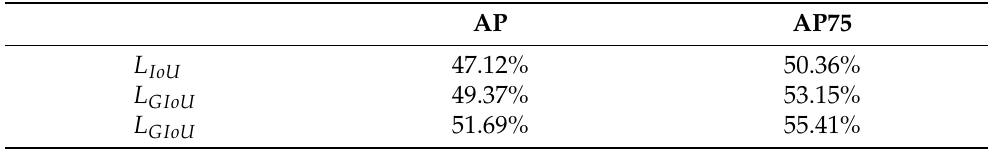
Table 4. Quantitative comparison of YOLOv3 (improved method in this article) trained using L IoU (baseline), L GIoU and L GIoU . The results are reported on the test set of DOTA.